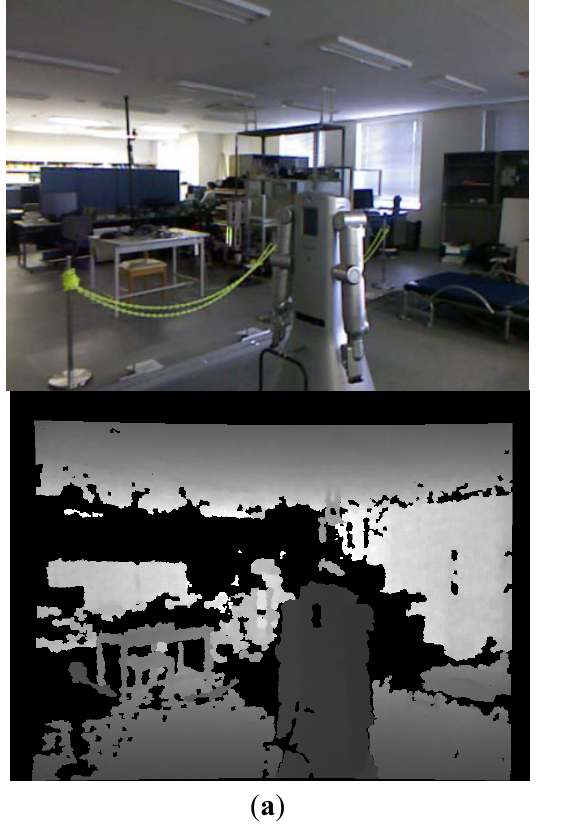
(upper) and T grey depth